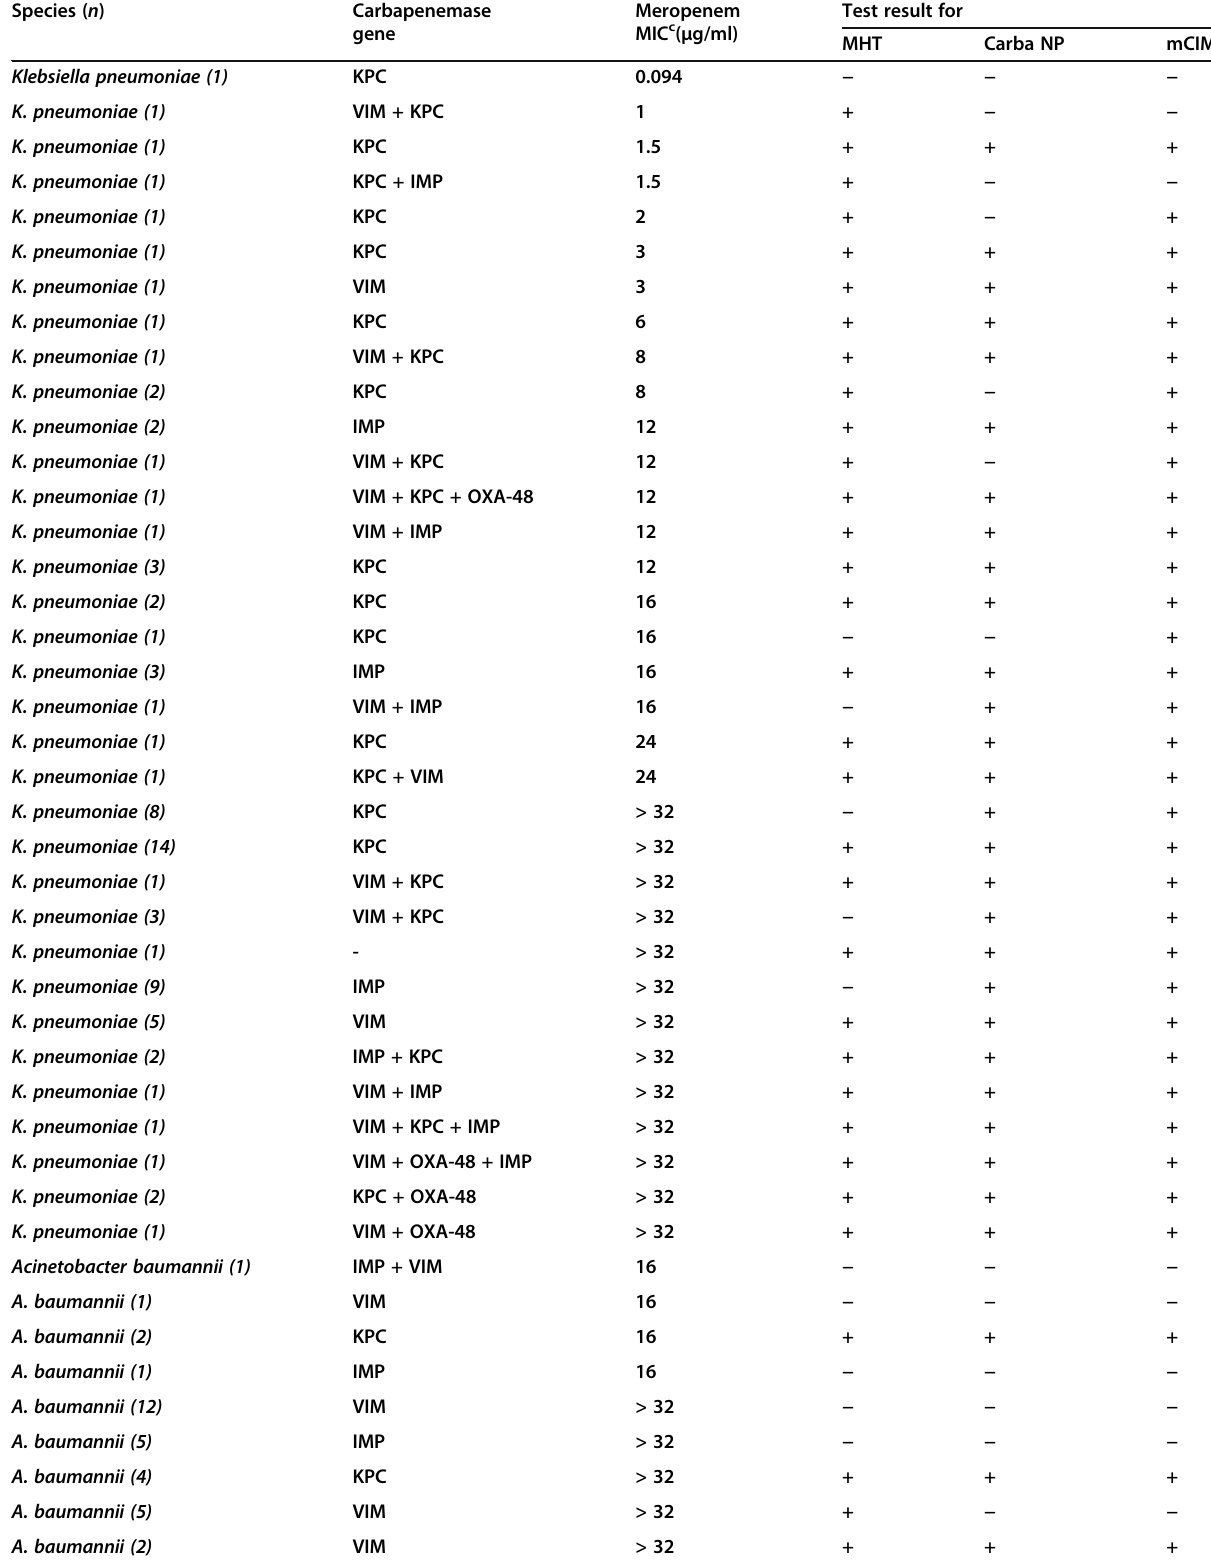
Table 3 The results of MHT a , Carba NP, and mCIM b for isolates tested ( n = 122) Species ( n